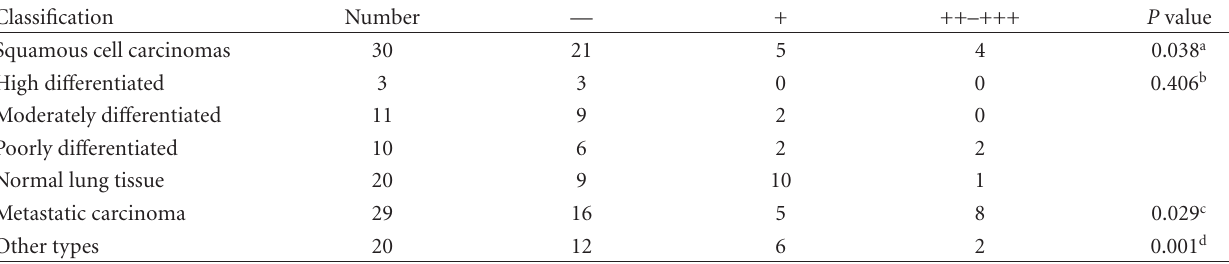
Table 3: SCCA1 expression in various tissues by